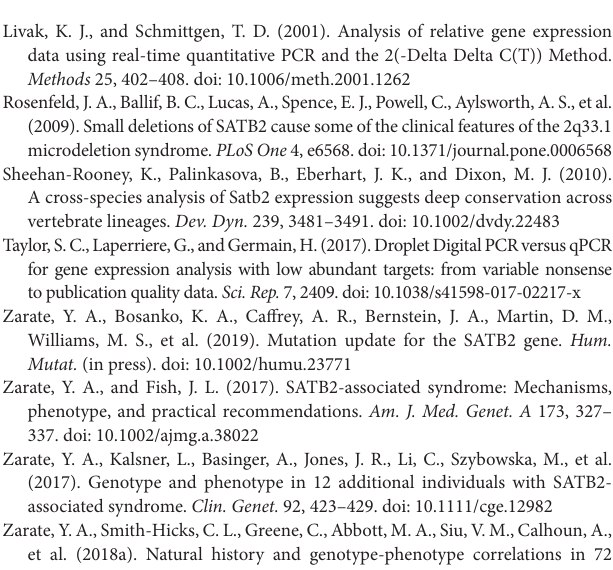
FIGURE S1 | CMA analysis of the proband, his sister, and their father and mother. The red arrows refer to the deletion. The black arrows refer to the normal copy in the deletion region. FIGURE S2 | Gap-PCR of the core family members using primer set (Gap2500- F/R). Lanes 1–5: Marker, II2, II1, III1, III2. Notice that II2 has one band about 10 kb in size, while the other three members have another band about 7 kb in size. FIGURE S3 | Gap-PCR of the father (II2) revealed heterozygous deletion in peripheral blood-derived and semen-derived DNA using primer set (4334-F/R). Lanes 1–3: Marker, blood, sperm. Notice that lane 3 has a lower band about 1.3 kb in size as lane 2. The PCR condition was as the same with that